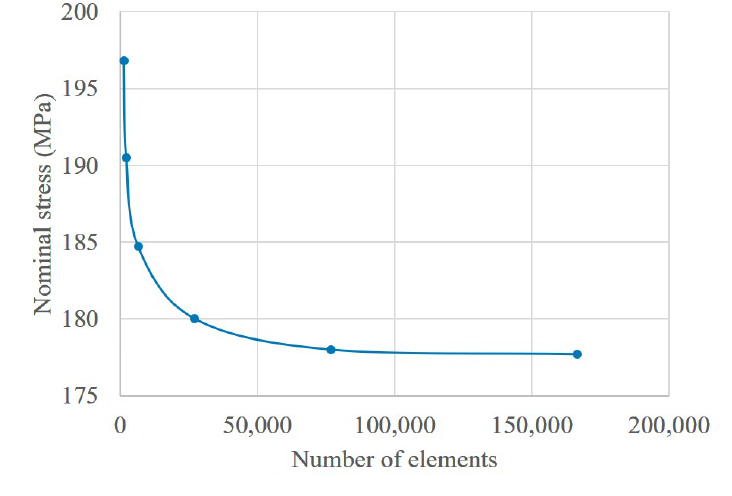
Figure 4. Convergence analysis of the FEA simulation